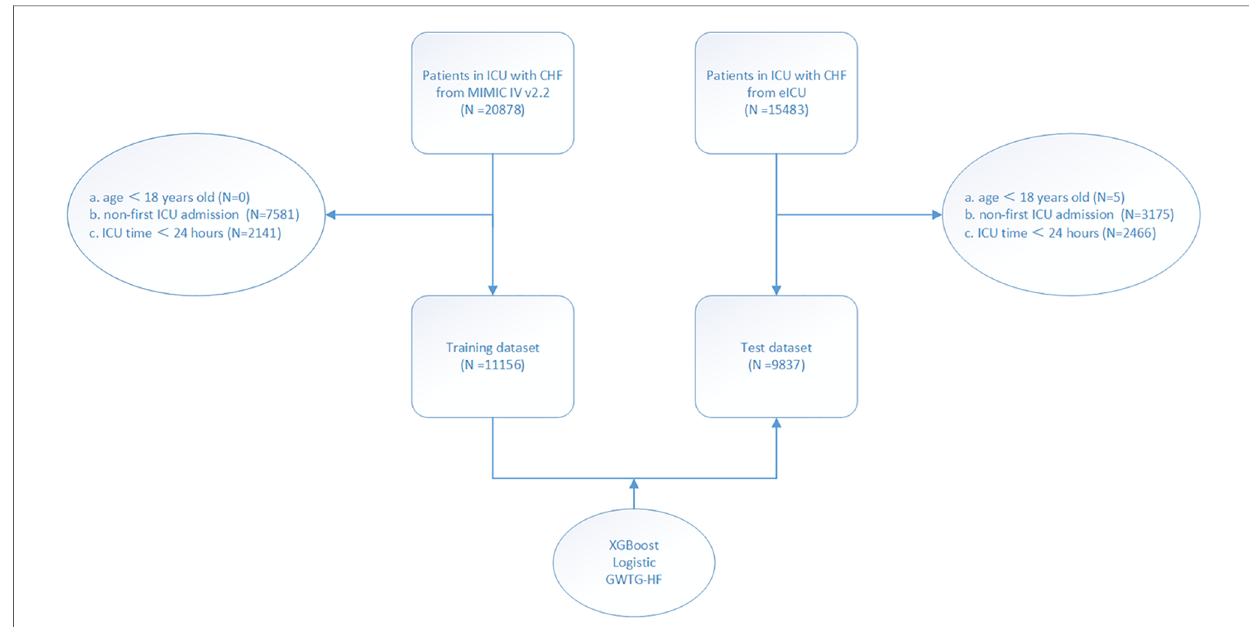
FIGURE 1 Study fl ow chart. According to the inclusion and exclusion criteria of the study, the population of the training set and the test set were